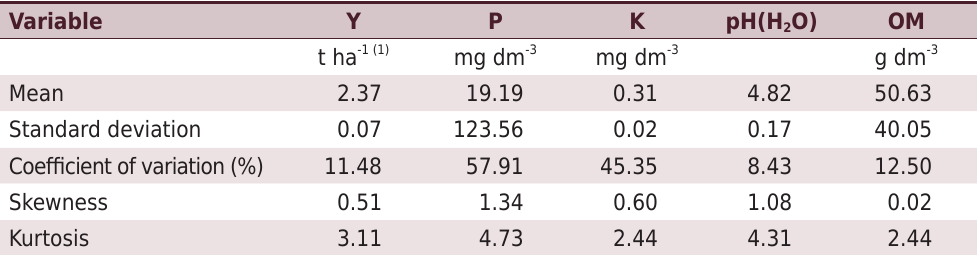
Table 1. Descriptive statistics of soybean yield (Y) and of the soil chemical properties